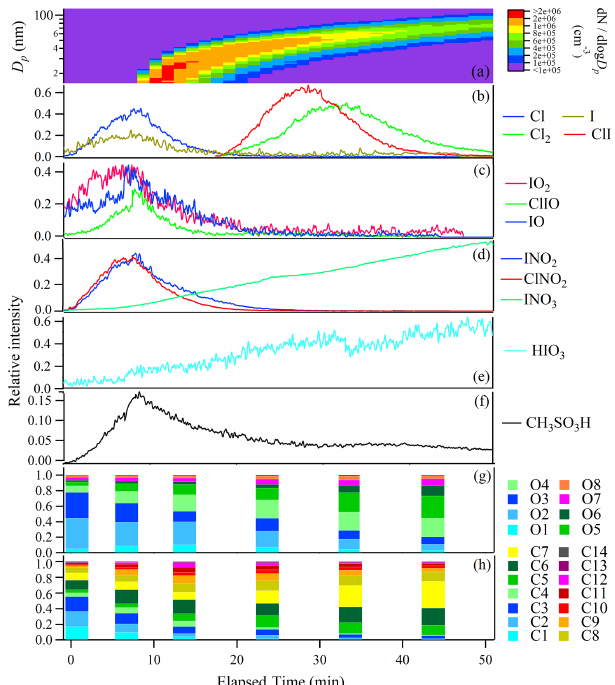
Figure 2. Time evolution of particle number size distribution (a) and relative intensities of gaseous molecules and radicals (b–f) ; the fractions of organic compounds grouped by O and C atom numbers in the selected time points (g–h) in a typical ozonolysis experiment (static mode). Time zero was set as the time when gaseous products first appeared.